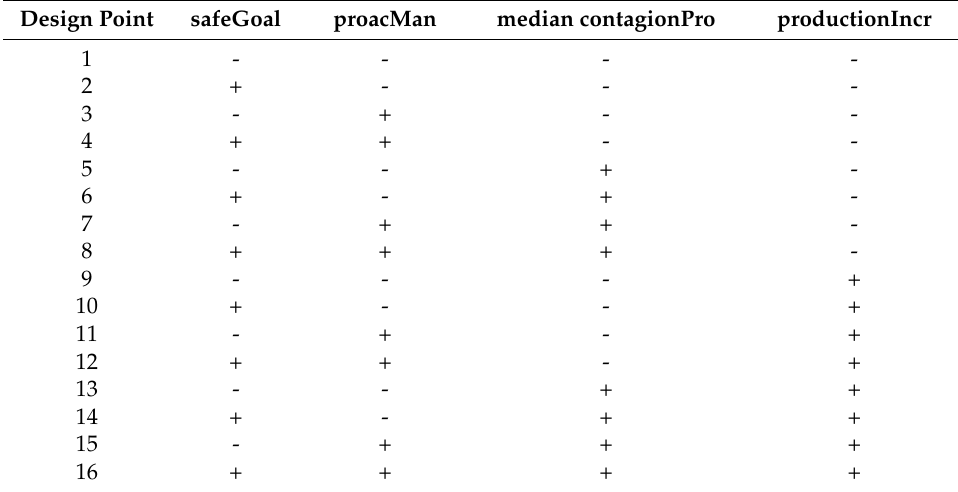
Table 5. Experimental design